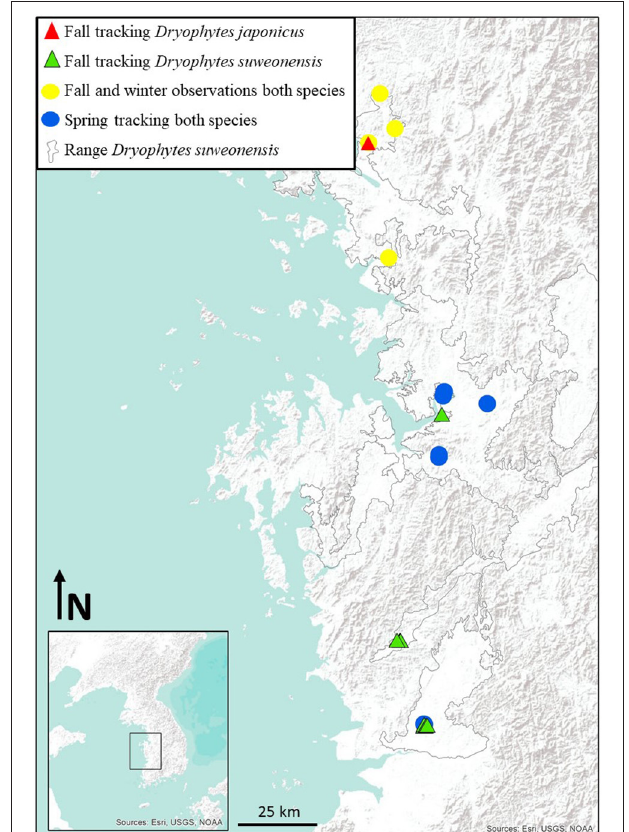
FIGURE 1 | Spatial location of the sites surveyed in this study. The map was generated with ArcMap 9.3 (Environmental Systems Resource Institute, Redlands, California, USA; http://www.esri.com/) and the range of the species is extracted from Borzée et al. (2017a).